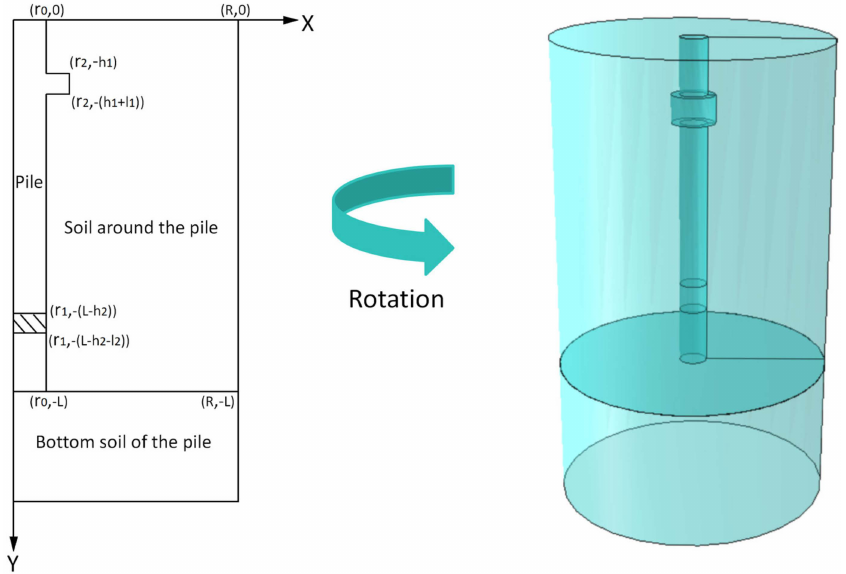
Figure 4. The process of model